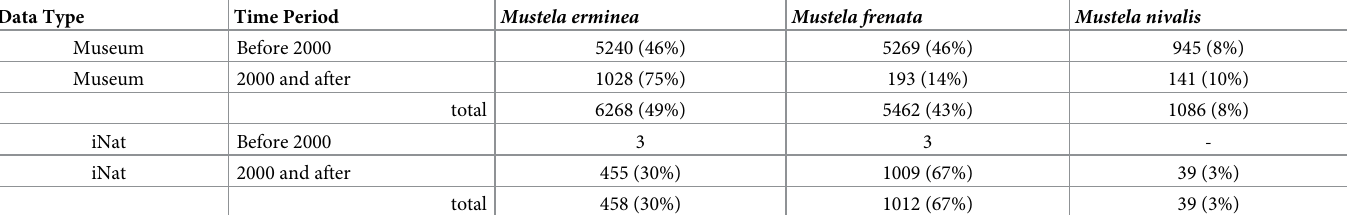
Table 3. Number of records (and proportion) by species for North American weasels archived as specimens in museums and as photographs in iNaturalist before and after the year 2000.